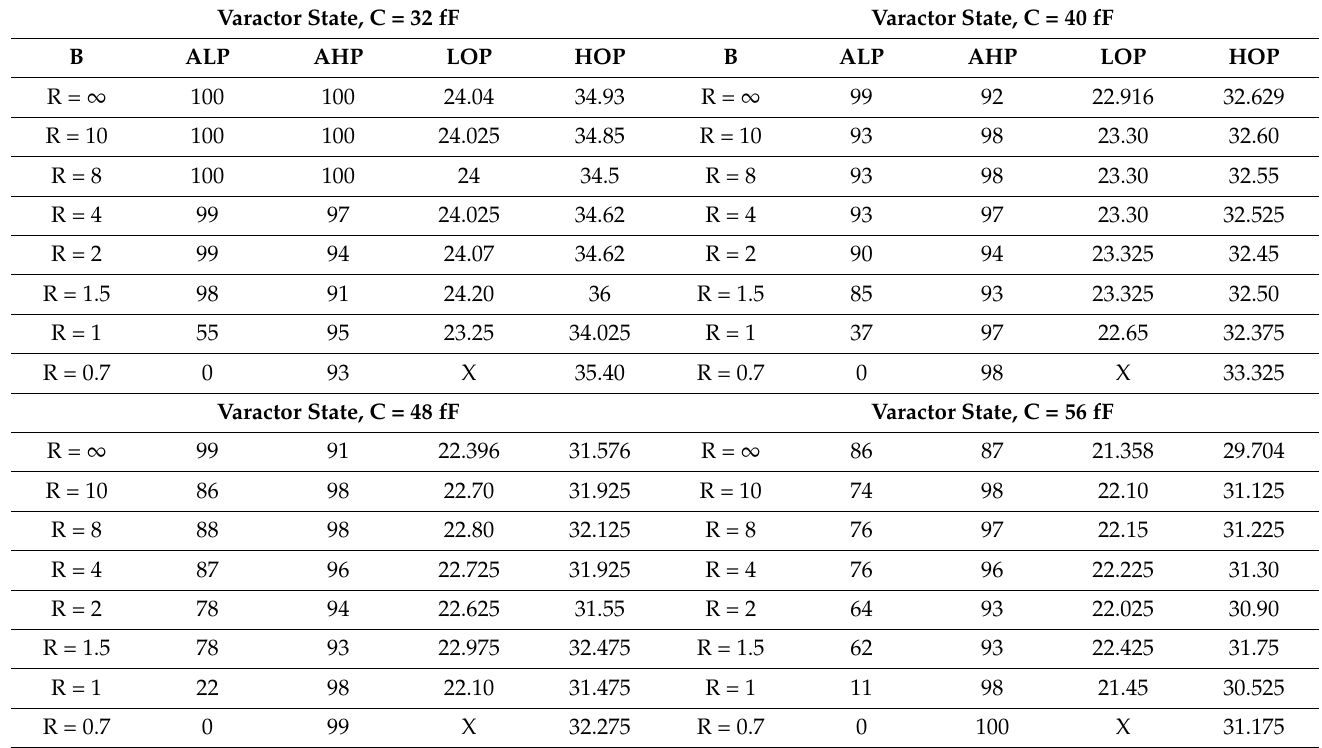
Table 1. Detailed bending analysis of the proposed MMA for different states of the varactor diode in tabulated form: there are four small tables, namely top left, top right, bottom left, and bottom right, etc. All the tables indicate the bending of the proposed MMA by fixing the varactor state for each case. In addition, Table 1 consists of different symbols, which are explained at the bottom of the table.